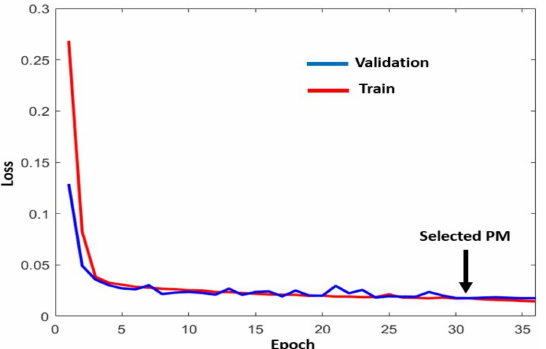
Figure 17. Evaluation curve for the X coordinate using real landing values.